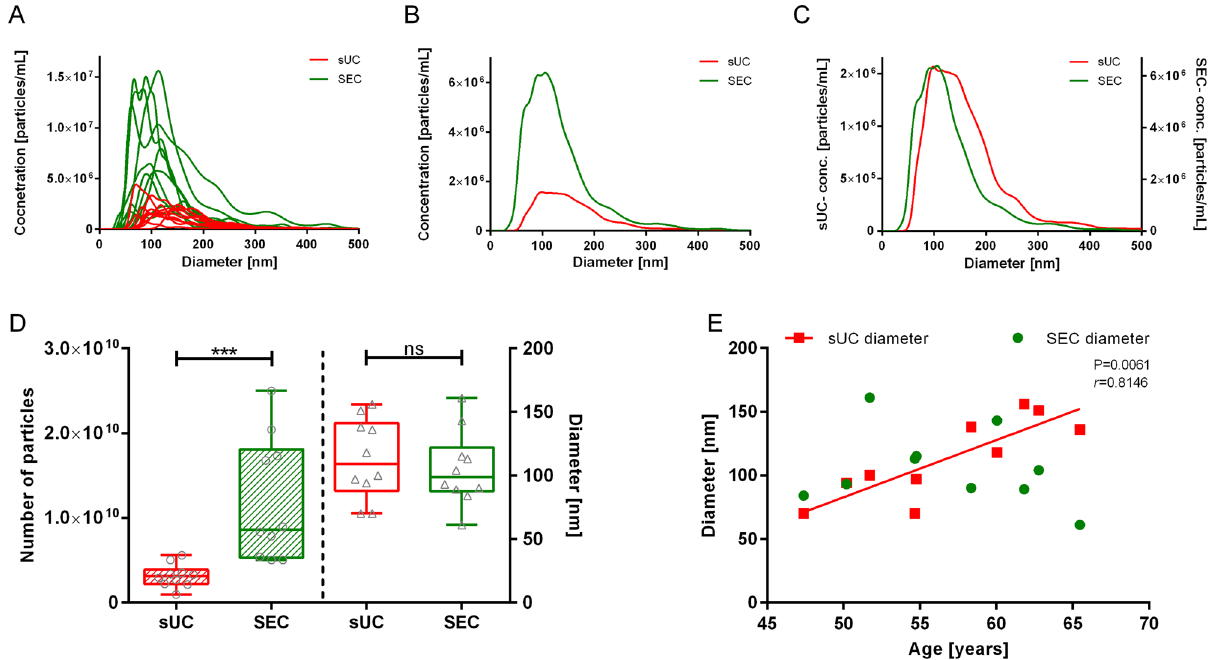
Figure 1. Quantification of enriched nanoparticles from human blood plasma by NTA. ( A ) NTA signal for samples of all included subjects after sUC and SEC. Comparison of the average particle ( B ) concentration and ( C ) size distribution for included subjects after sUC and SEC. ( D ) Box and whiskers plot of particle concentration and size in samples after sUC and SEC. Each circle or diamond presents one sample. *** p < 0.001. ( E ) Correlation of particle mode diameter after EVs-enrichment with age of the study subjects: SEC: p = 0.5603; sUC p = 0.0061, r